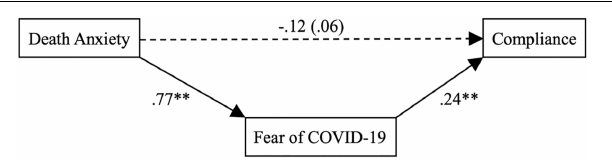
FIGURE 1 | Mediation model for the influence of death anxiety on compliance with COVID-19 regulations through fear of COVID-19. N = 313. The value in parentheses represents the direct effect of death anxiety on compliance with COVID-19 regulations without controlling for fear of COVID-19. ∗∗ p < 0.01.